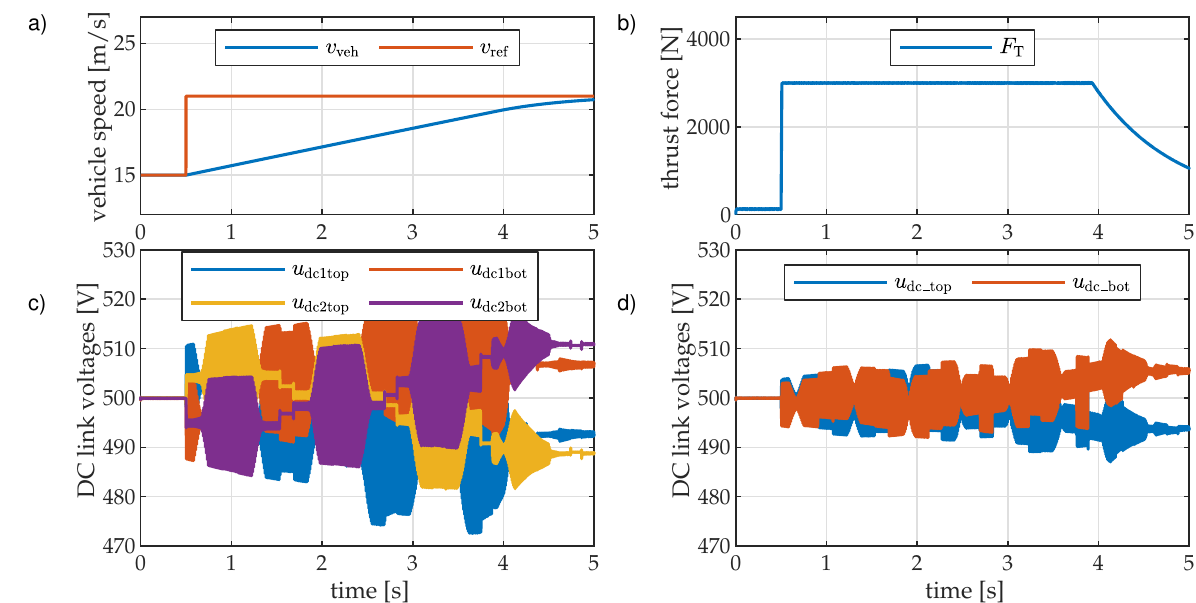
Figure 15. Comparison of DC voltage balancing effectiveness—simulation results. ( a ) commanded and vehicle speed, ( b ) thrust force, ( c ) DC voltages in the system presented in Figure 10a, ( d ) DC voltages in the system presented in Figure 10b.